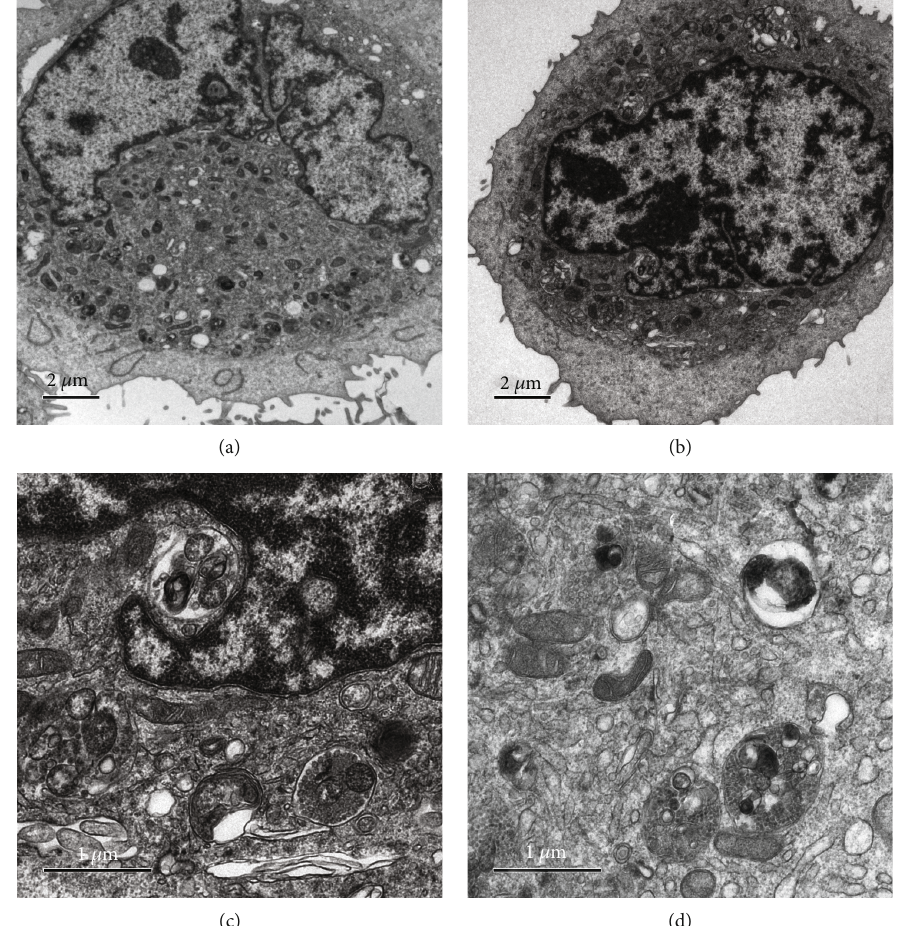
Figure 5: TPC-1 electron microscope image after nsPEF processing. For (a) and (b), the magni fi cation is 2500, while for (c) and (d), the magni fi cation is